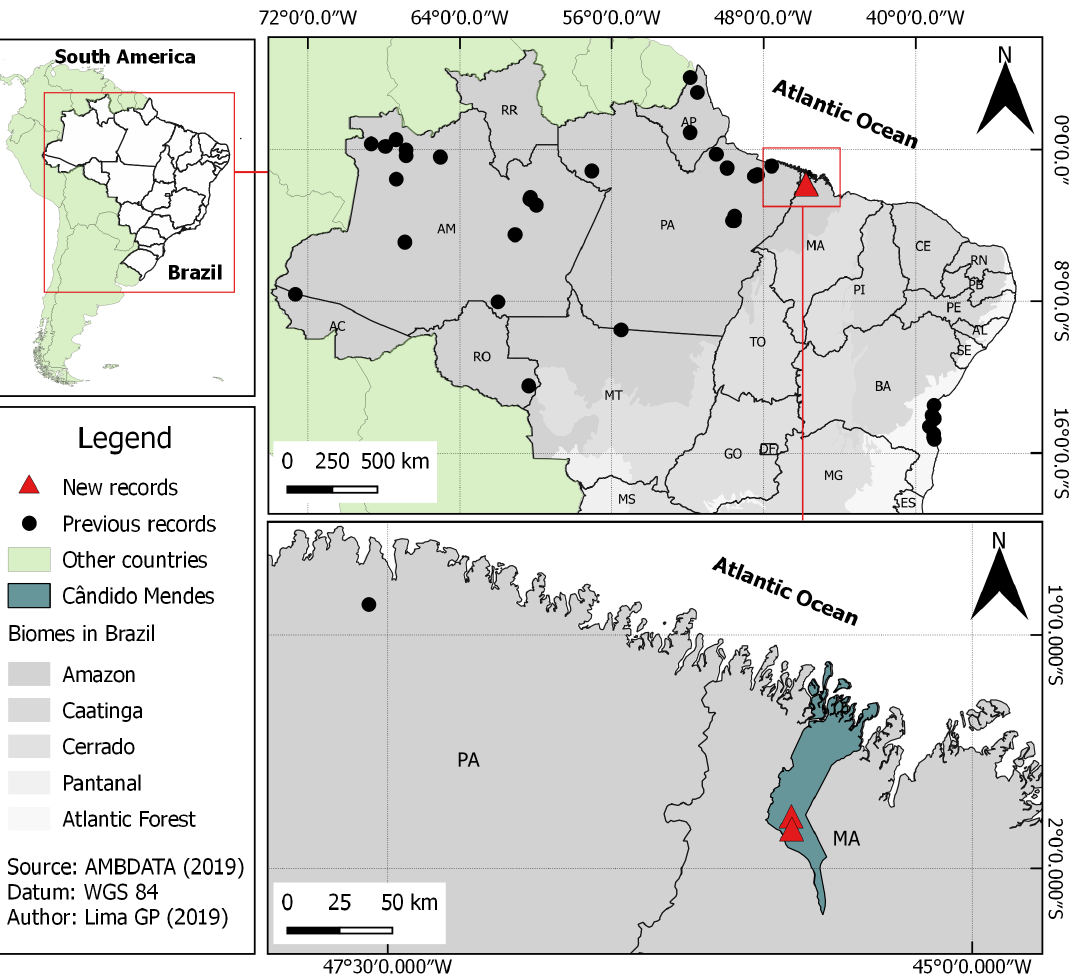
Figure 1. Collection sites of Rapatea paludosa Aubl. on the Brazilian territory, highlighting the location of the new records in the munici- pality of Cândido Mendes, Maranhão